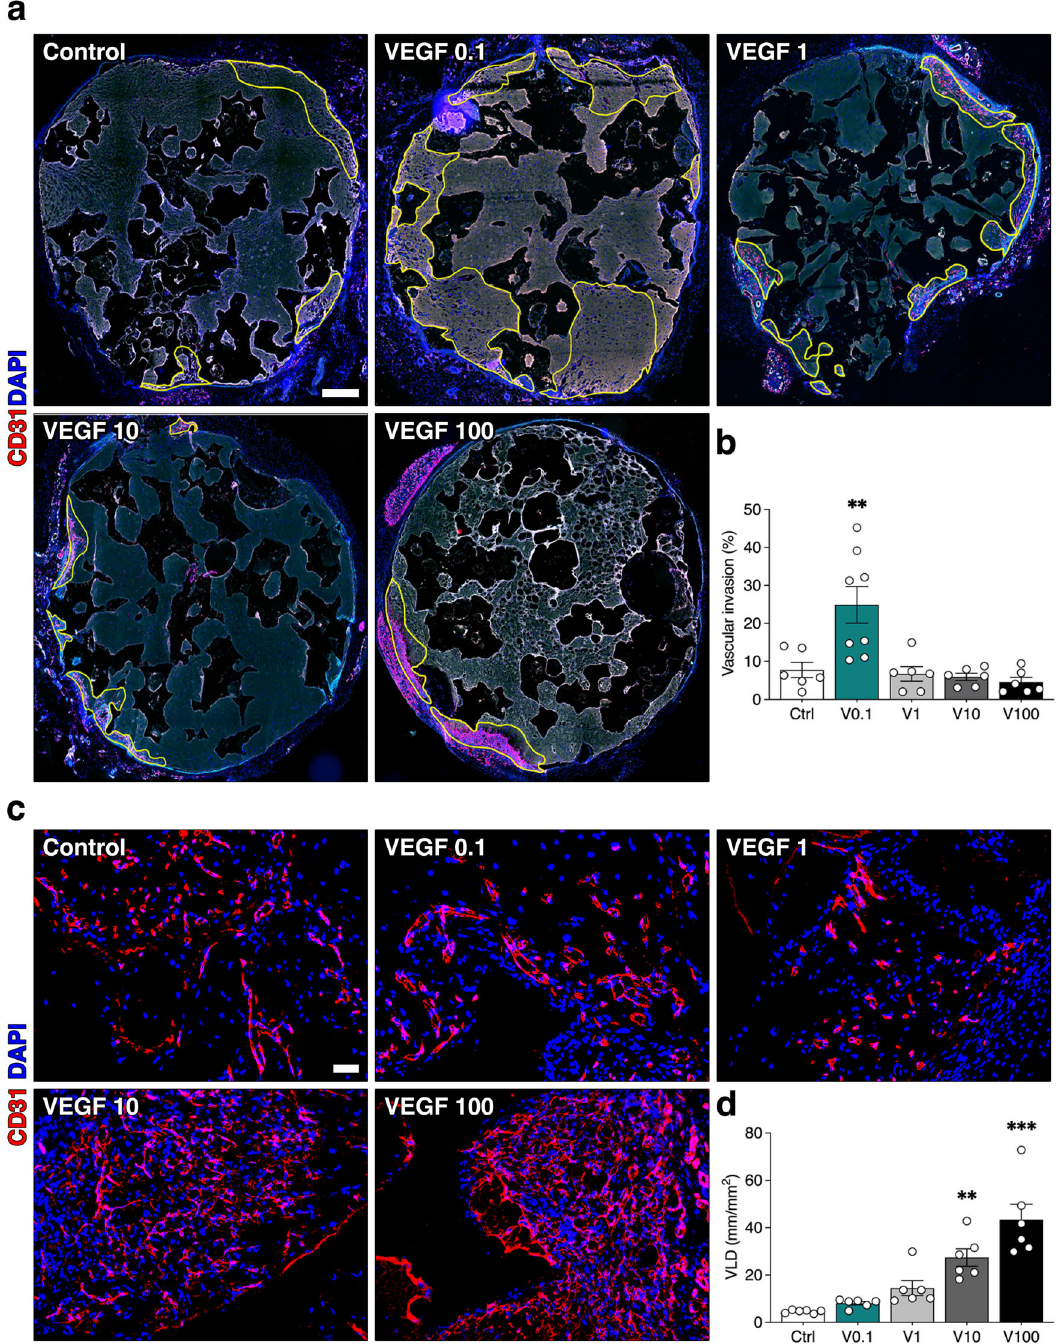
Fig. 2 Blood vessel invasion of osteogenic constructs after 1 week of in vivo implantation. a Reconstruction of graft sections under fl uorescence microscopy to elucidate the areas of blood vessel growth (in yellow), with TG-VEGF doses ranging from 0 to 100 µg/ml; b Quanti fi cation of the areas invaded by blood vessels (expressed as % of total section area); c Assessment of angiogenesis in the invaded areas. Immunostaining of endothelium (CD31, in red) and nuclei (DAPI, in blue) of areas invaded by blood vessels after 1 week of in vivo implantation, with TG-VEGF doses ranging from 0 to 100 µg/ml; d Quanti fi cation of induced angiogenesis, after 1 week in vivo, expressed as VLD (vessel length density), calculated as millimeters of vessel length per square millimeter of tissue area (mm/mm 2 ). Values are expressed as mean ± s.e.m.; ** p < 0.01, *** p < 0.001. N = 6 – 8. Scale bars ( a ) = 500 µm; ( c ) = 100 compared to controls (Control = 1.8 ± 0.2%, TG-VEGF 0.1 = 4.0 ± 0.6%; p < 0.01). However, 1 µg/ml TG-VEGF negated this improve- ment (TG-VEGF 1 = 2.0 ± 0.5%; p = n.s. vs Control and p < 0.01 vs